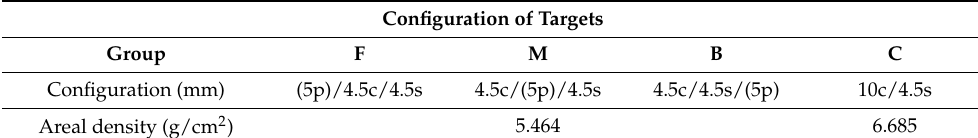
Table 3. Target design.